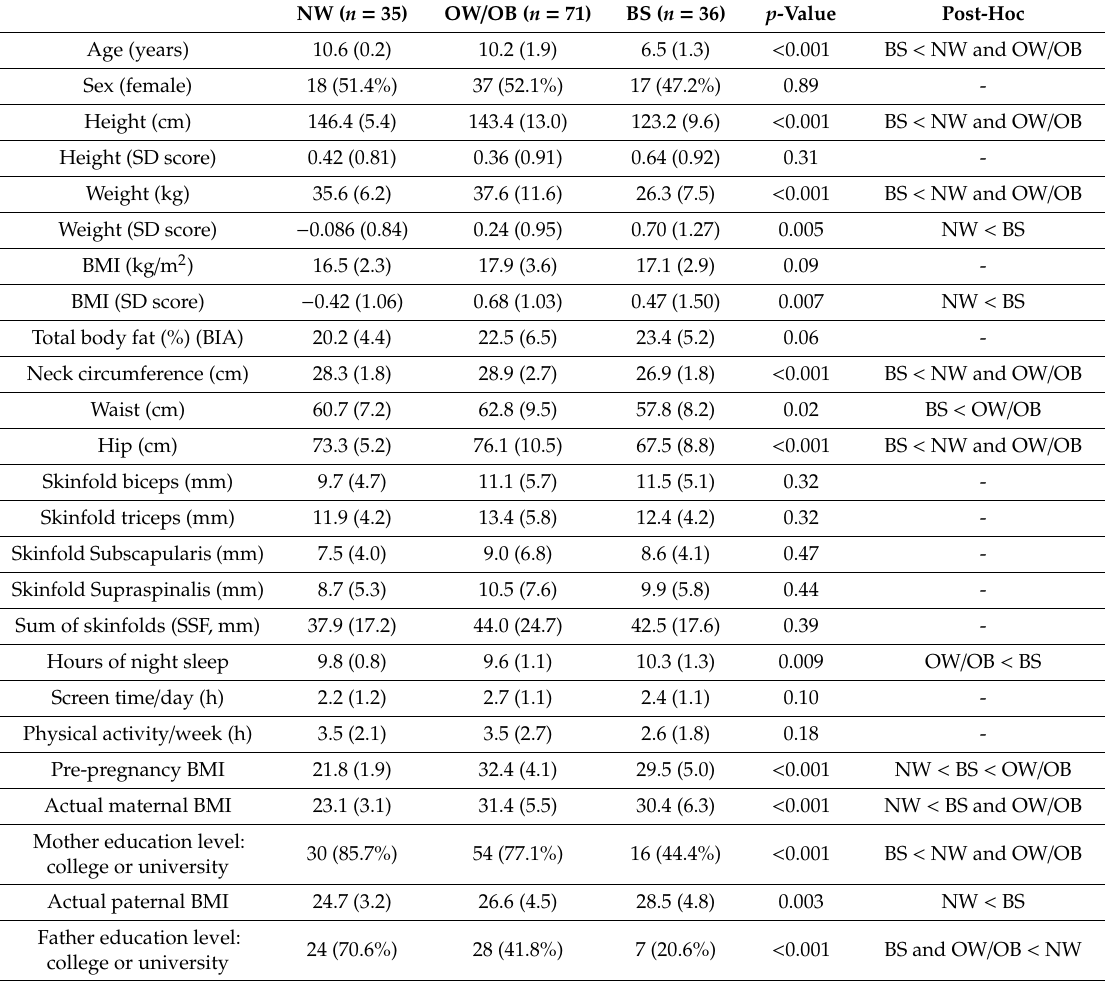
Table 1. Overall population characteristics.